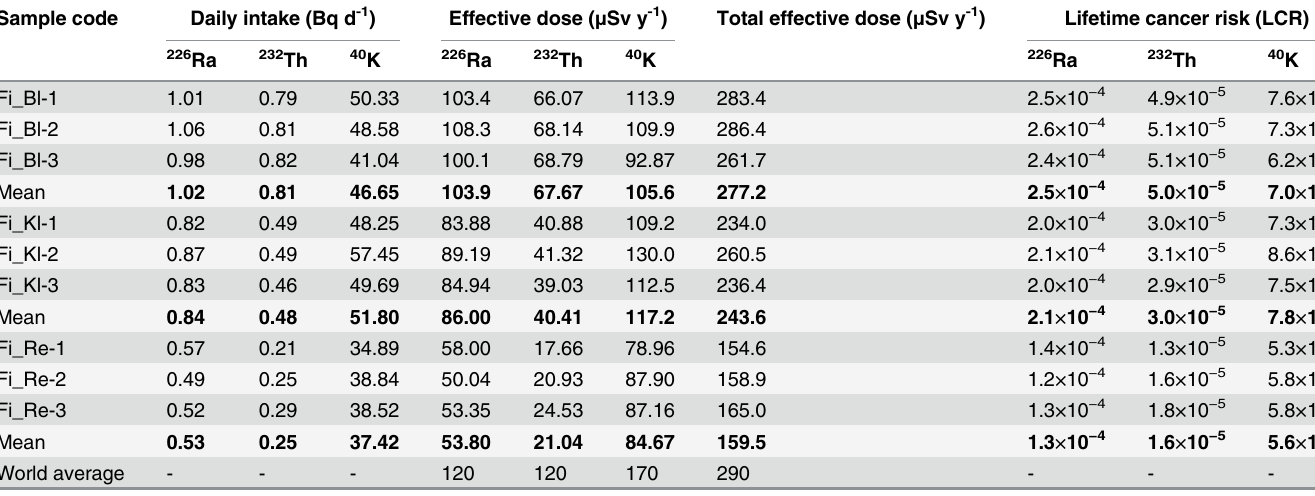
Table 4. Annual effective dose ( μ Sv y -1 ) and life time cancer risk due to the comsumption of natural radionuclide from the marine fish. Sample